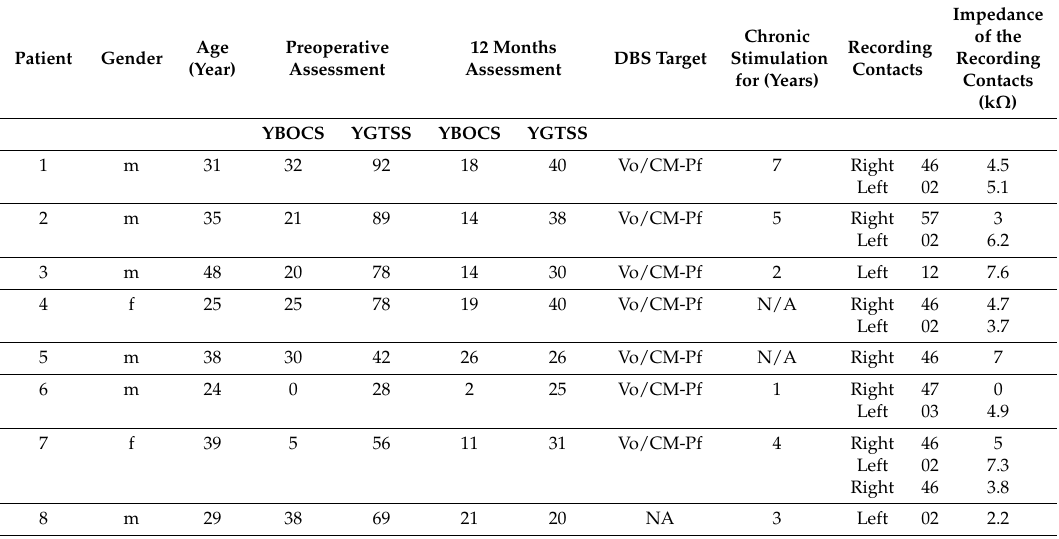
Table 3. Demographic and deep brain stimulation (DBS) details of the patients recorded in the chronic